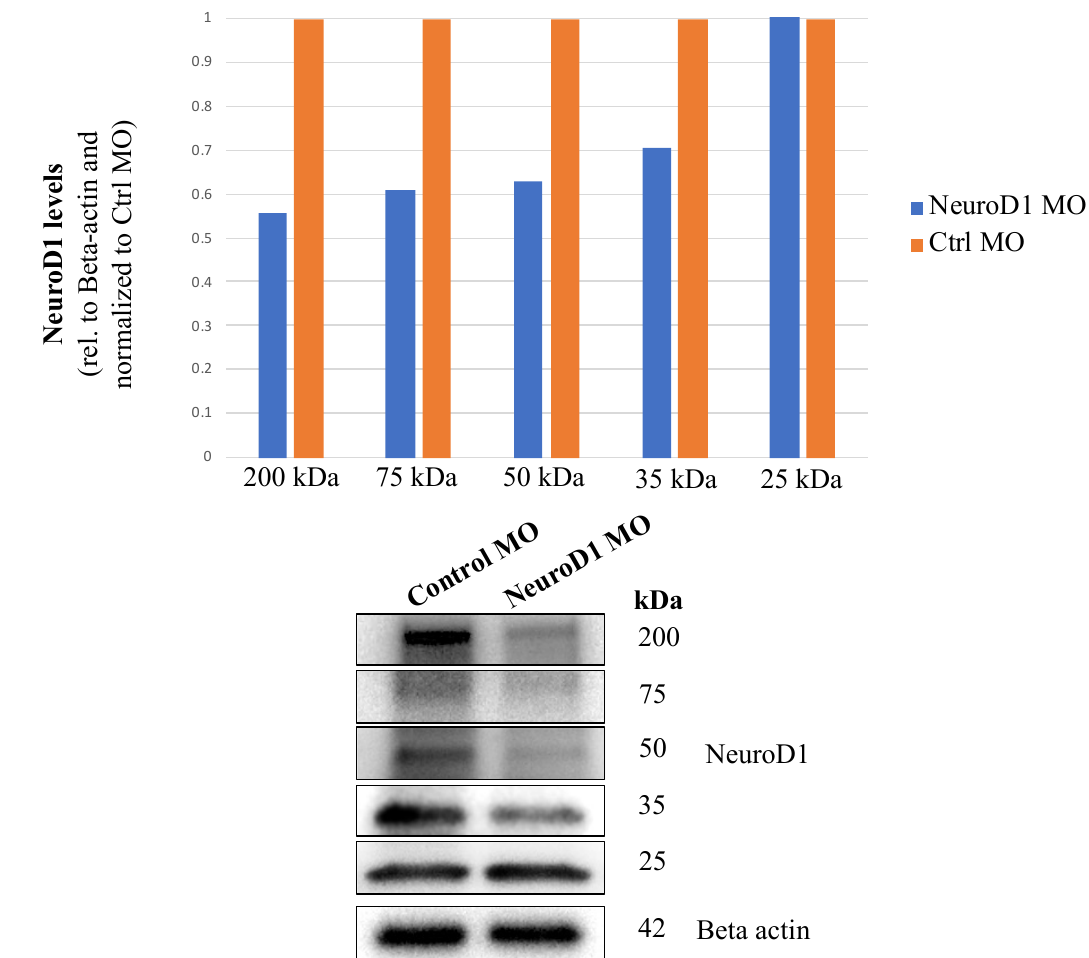
Figure 5. The NeuroD1 MO reduces NeuroD1 protein levels. At ~E1.5 (HH9+ to 10), placode cells were unilaterally electroporated either with a NeuroD1 or control (Ctrl) MO. After re-incubation to E2.5–3 (HH16–18), the forming trigeminal ganglion on the electroporated side was dissected and pooled from multiple embryos. Lysates were prepared, and equivalent amounts of protein per sample were separated on a 10% SDS-PAGE gel. Immunoblotting for NeuroD1 and Beta actin (control) was then performed, and band intensity was calculated from unmodified immunoblot images using Image Lab software (Bio-Rad). Relative protein levels were ascertained by normalizing NeuroD1 volumes to Beta actin volumes. Knockdown amount was determined by comparing normalized ratios between Ctrl MO and NeuroD1 MO samples, with the Ctrl MO sample set as one. The 25 kDa band is a background band given that the level of NeuroD1 protein was not changed between the control and NeuroD1 MO-treated samples.